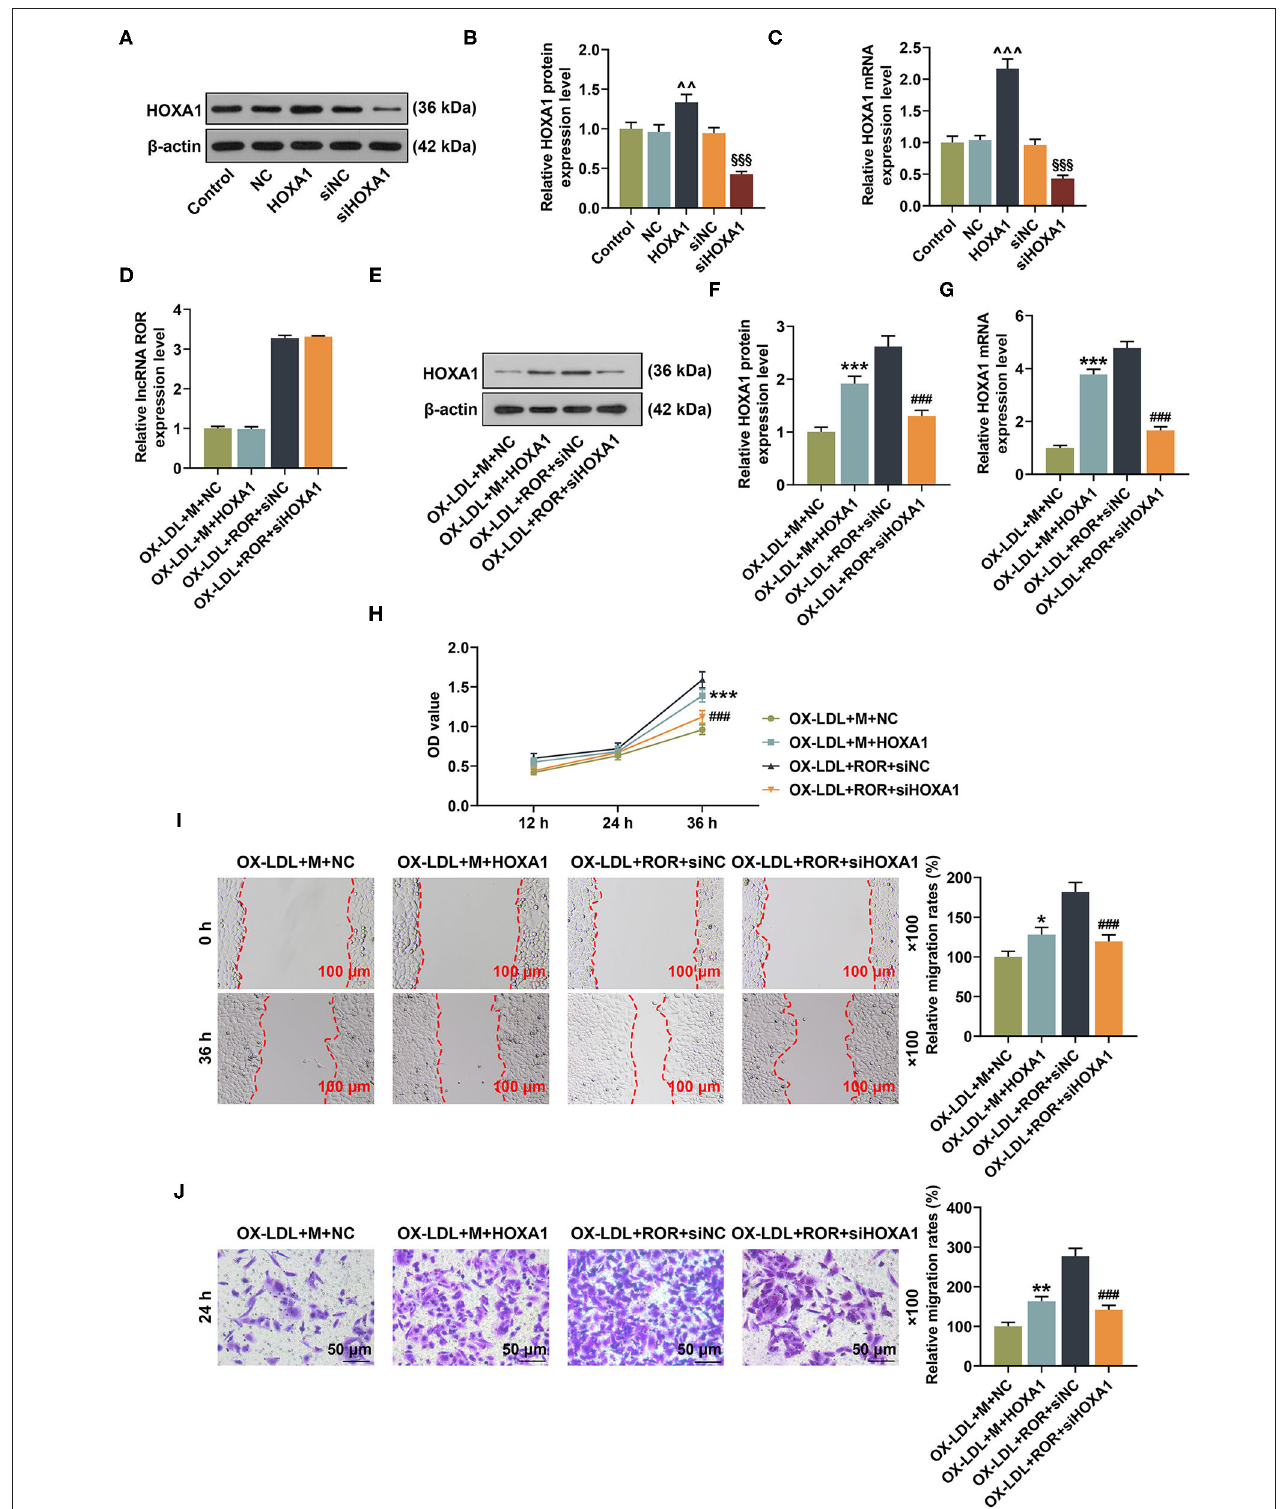
FIGURE 6 | The roles and functions of lncRNA ROR, let-7b-5p, and HOXA1 on HOXA1 expression as well as cell viability and migration of ox-LDL-treated human umbilical vein endothelial cells (HUVECs). (A–C) After the HUVECs were transfected with HOXA1 overexpression plasmids or siHOXA1, the protein and